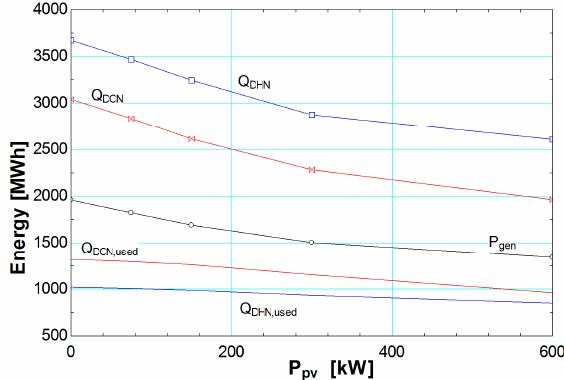
Figure 6. Parametric study: annual useful energy output for different photovoltaic subsystem capacities ranging from 0 to 600 kW e .